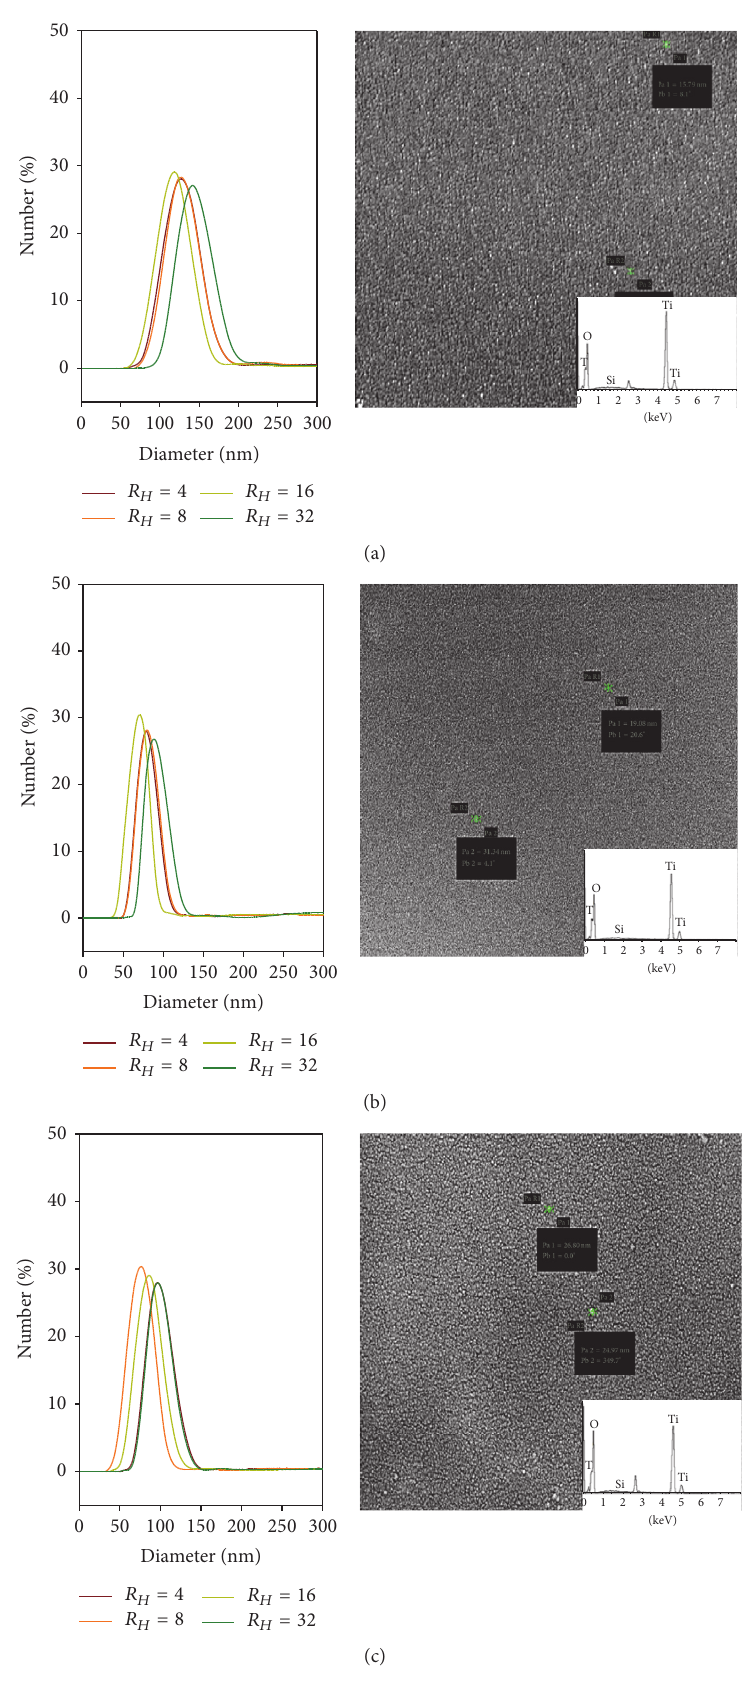
Figure 1: Particle size data and SEM micrograph: (a) HCl-THF/TiO 2 , (b) HNO 3 -THF/TiO 2 , and (c) ClHNO 2 -THF/TiO 2